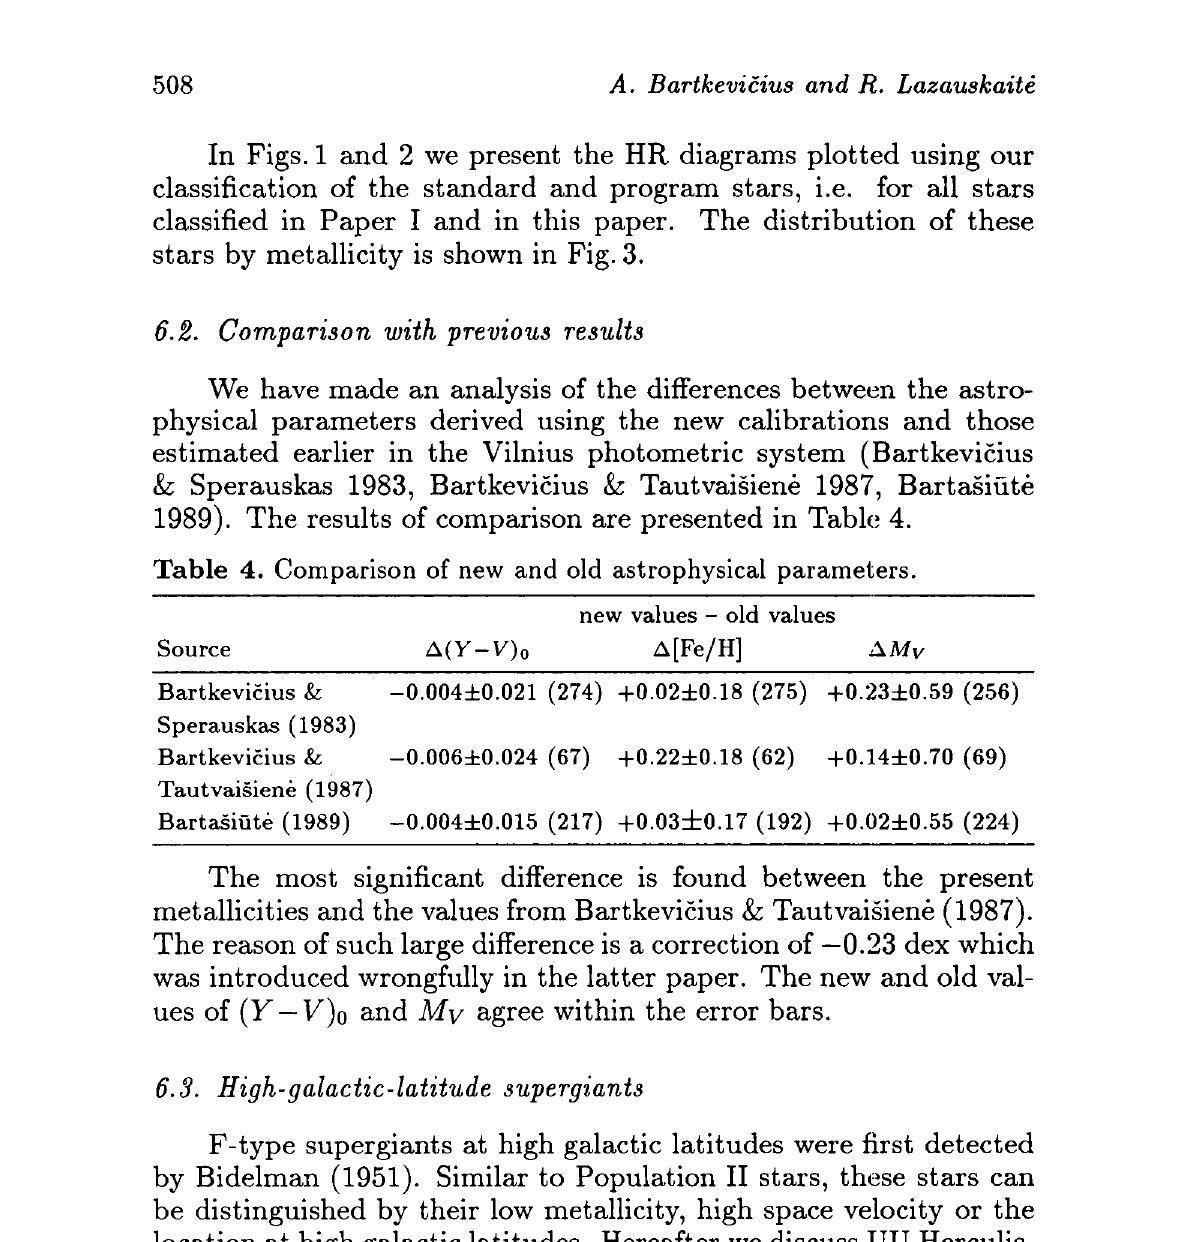
Table 4. Comparison of new and old astrophysical parameters. new values - old